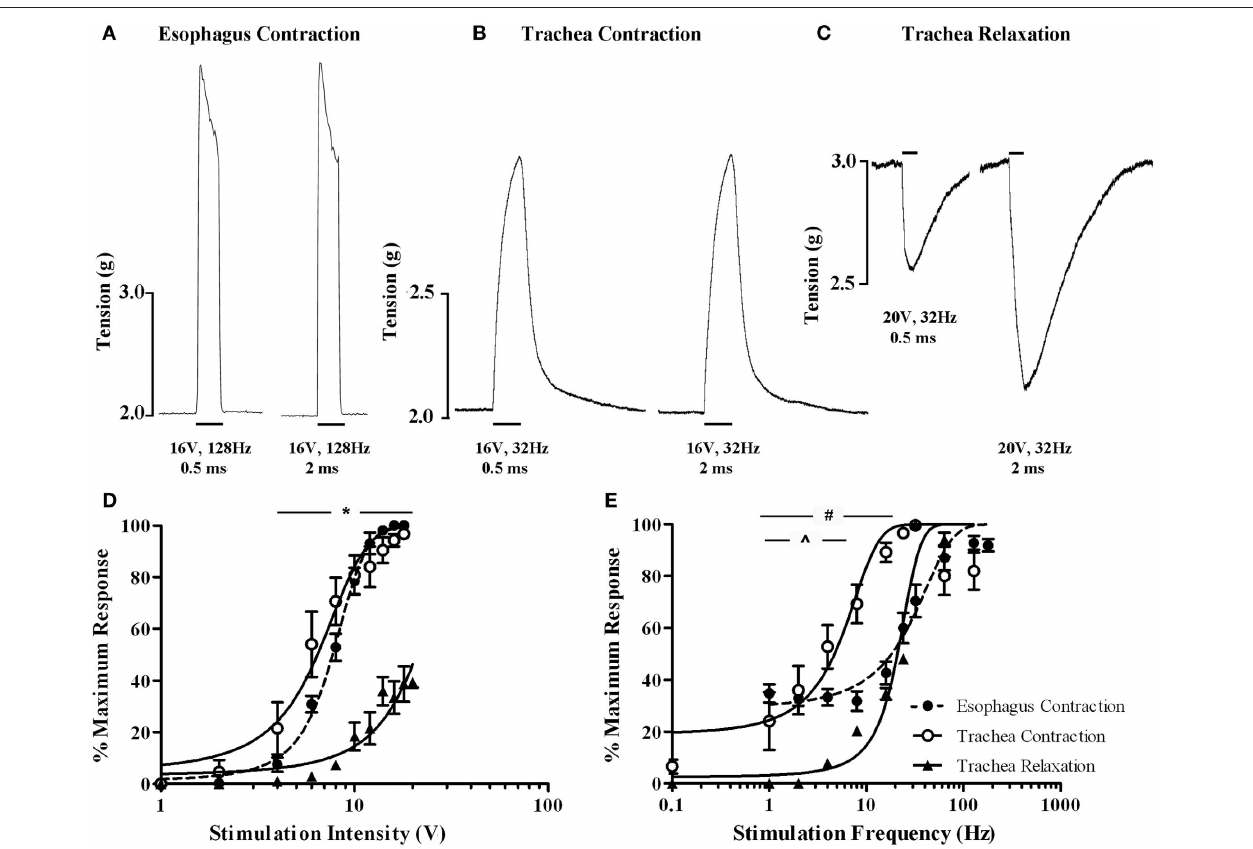
pulse duration was set at either 0.5 ms for esophageal and tracheal contractions or 2 ms for tracheal relaxations (as 0.5 ms was insufficient to generate consistent frequency dependent responses). Each data point represents the peak percentage response at a given stimulus relative to the absolute maximal attainable response irrespective of stimulus parameters. *Peak tracheal relaxations P < 0.05) significantly different to peak tracheal and esophageal contractions. # Peak tracheal relaxations significantly ( P < 0.05) different to peak tracheal contractions. ^Peak tracheal relaxations significantly ( P < 0.05) different to peak esophageal contractions. See text for calculated voltage and frequency